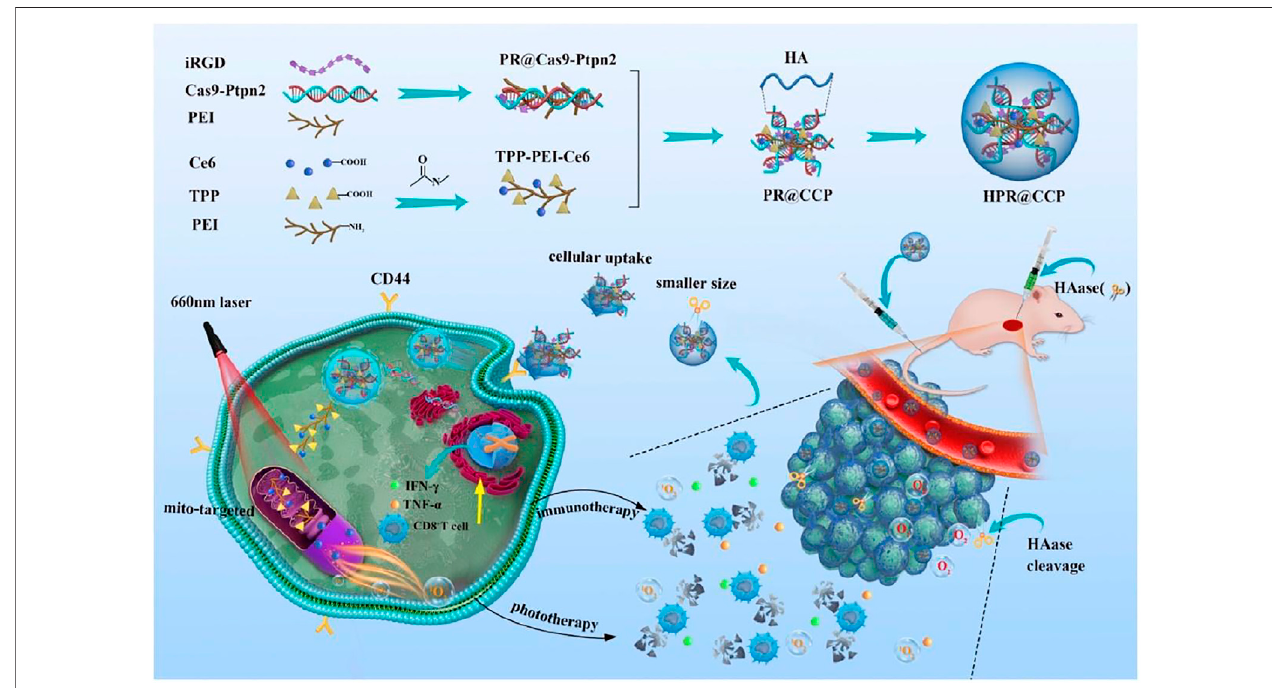
FIGURE7| TheconstructionofHPR@CCPnanoparticlesandtheirversatileapplicationincancercombinedtherapy.ReproducedwithpermissionfromYangetal. (2020). Copyright (2020) Elsevier.